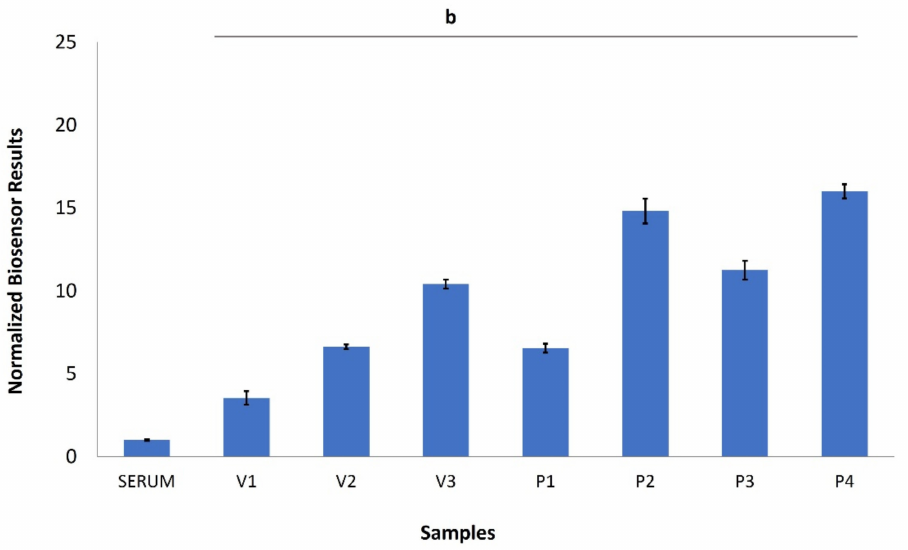
Figure 3. Normalized biosensor responses against human blood serum samples derived from three vaccinated donors (V1, V2, V3) and four COVID-19 patients. (P1, P2, P3, P4) As a control an average of ten (10) healthy individuals that were not previously vaccinated was used. Membrane-Engineered SK- N-SH cells with 5 µ g/mL S1 protein were used as the biorecognition element (n = 24). b: statistically significant different results ( p < 0.001).